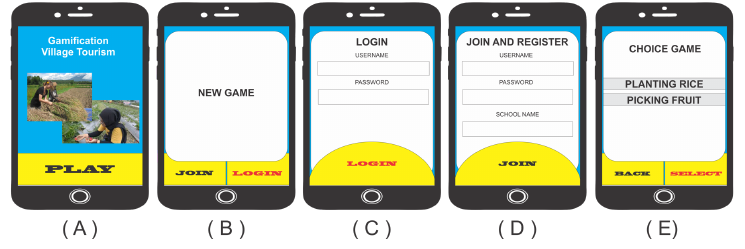
Fig. 4. Interface design for preparing the